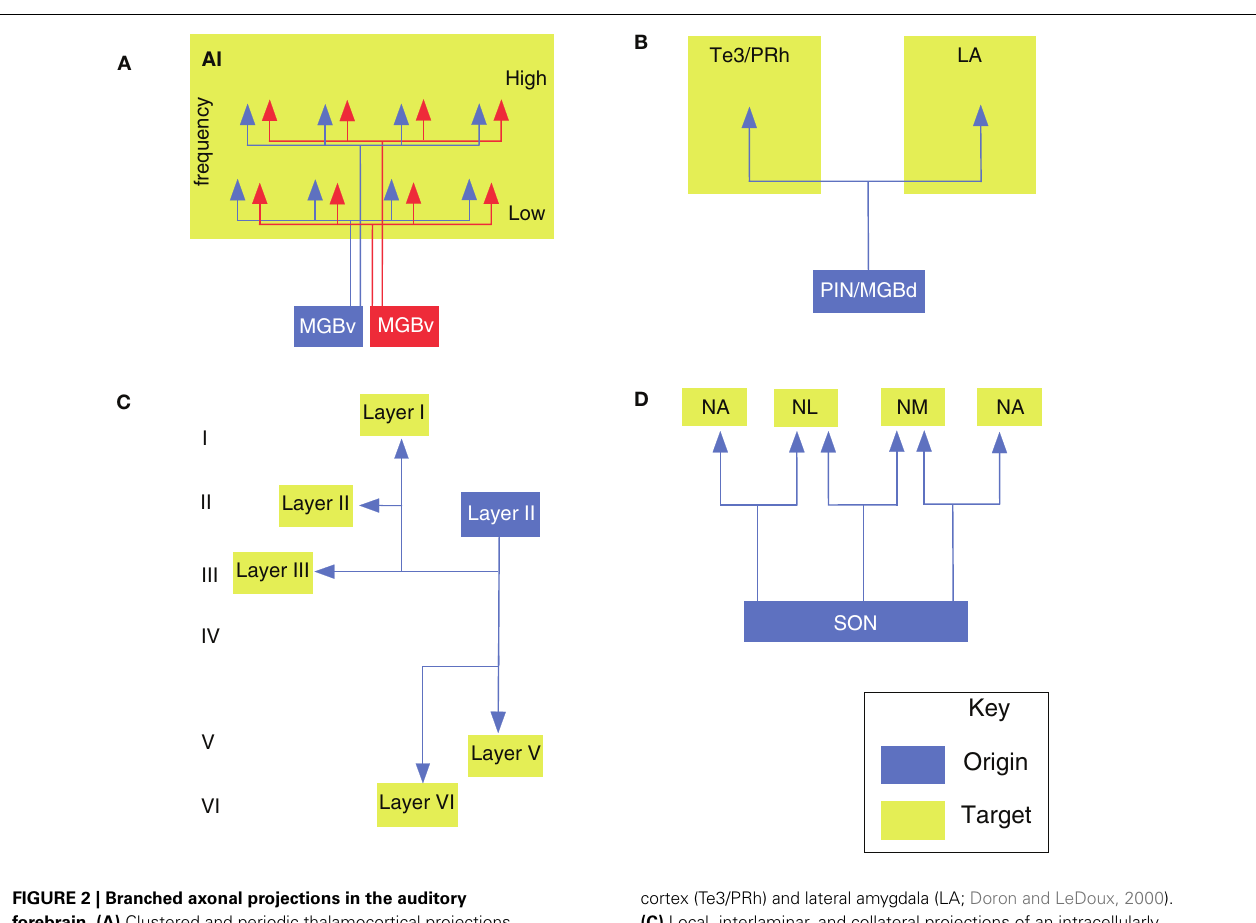
FIGURE 2 | Branched axonal projections in the auditory forebrain. (A) Clustered and periodic thalamocortical projections from medial geniculate body subdivisions to area AI (Velenovsky et al., 2003). (B) Posterior intralaminar (PIN) and dorsal division of the medial geniculate body branched projections to the non-primary auditory